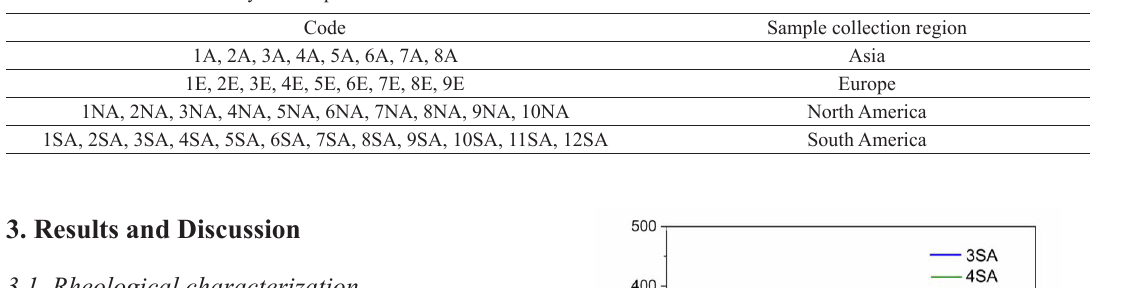
Table 2. Codes used to identify the samples.